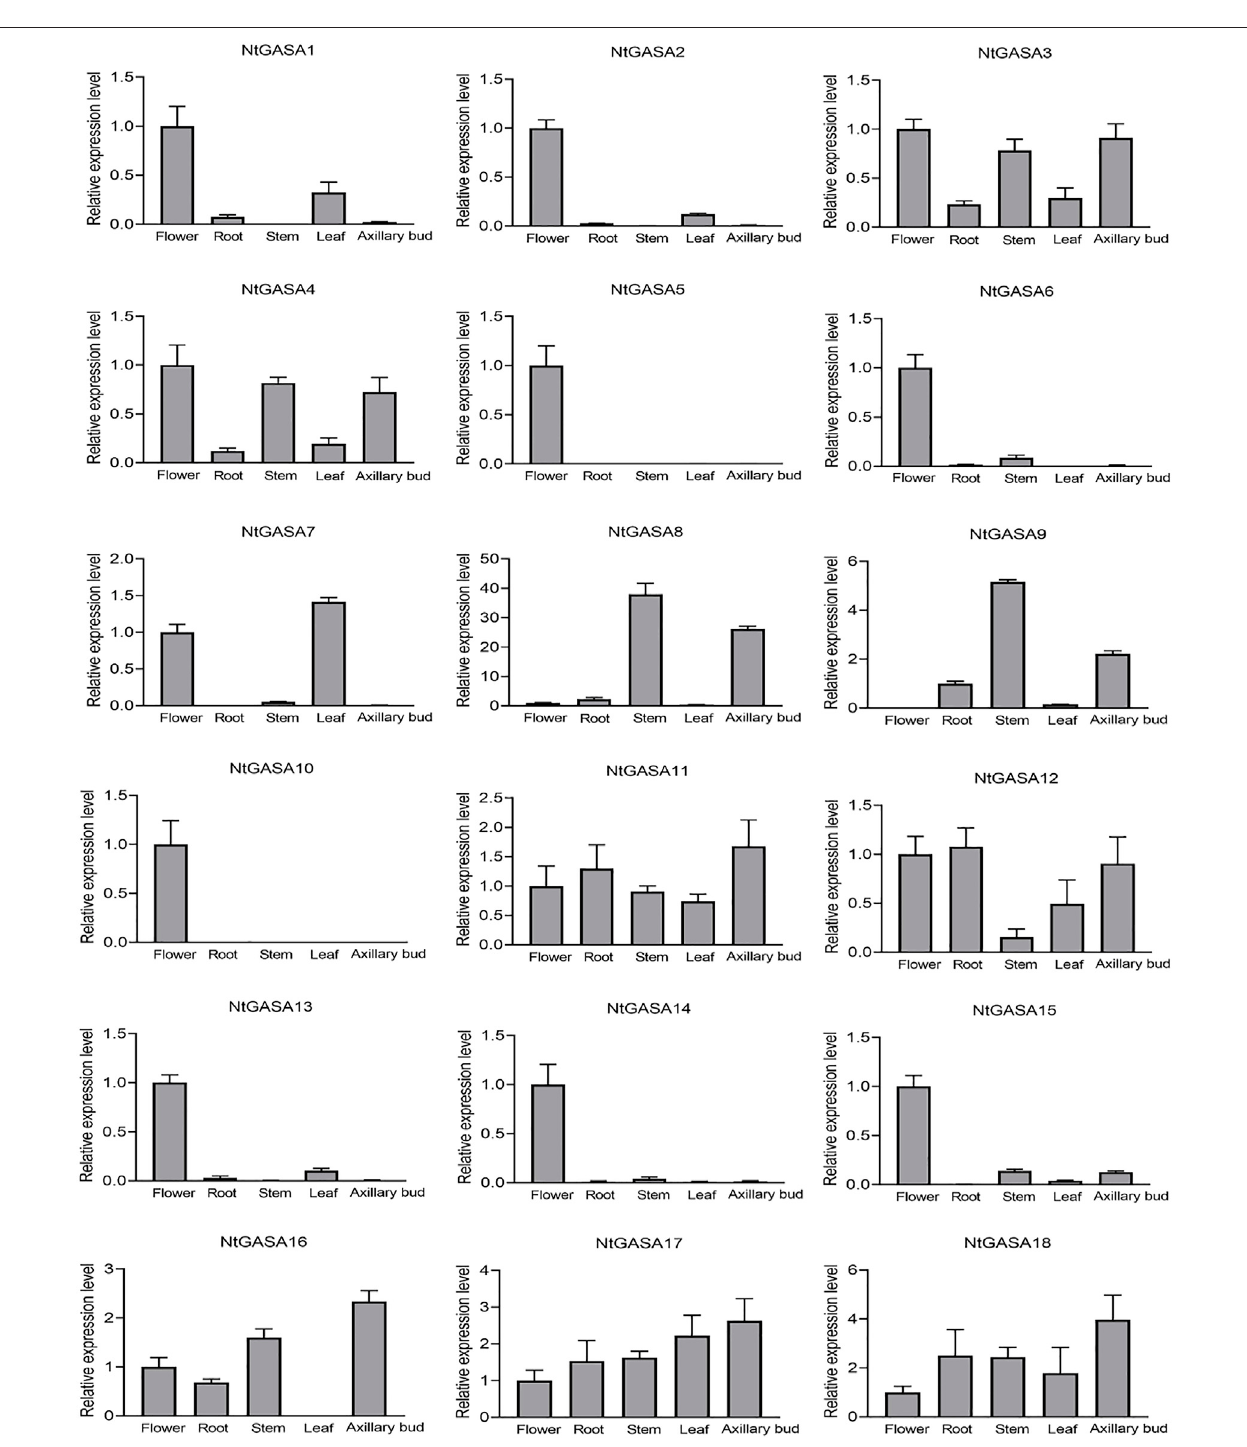
FIGURE 6| Expression patterns of NtGASA genesin different tissues and organs. Transcriptlevels in fl owers were set to one, in NtGASA9 , transcriptlevels in root was set to one. Each value represents the mean ± standard error of three biological replicates.